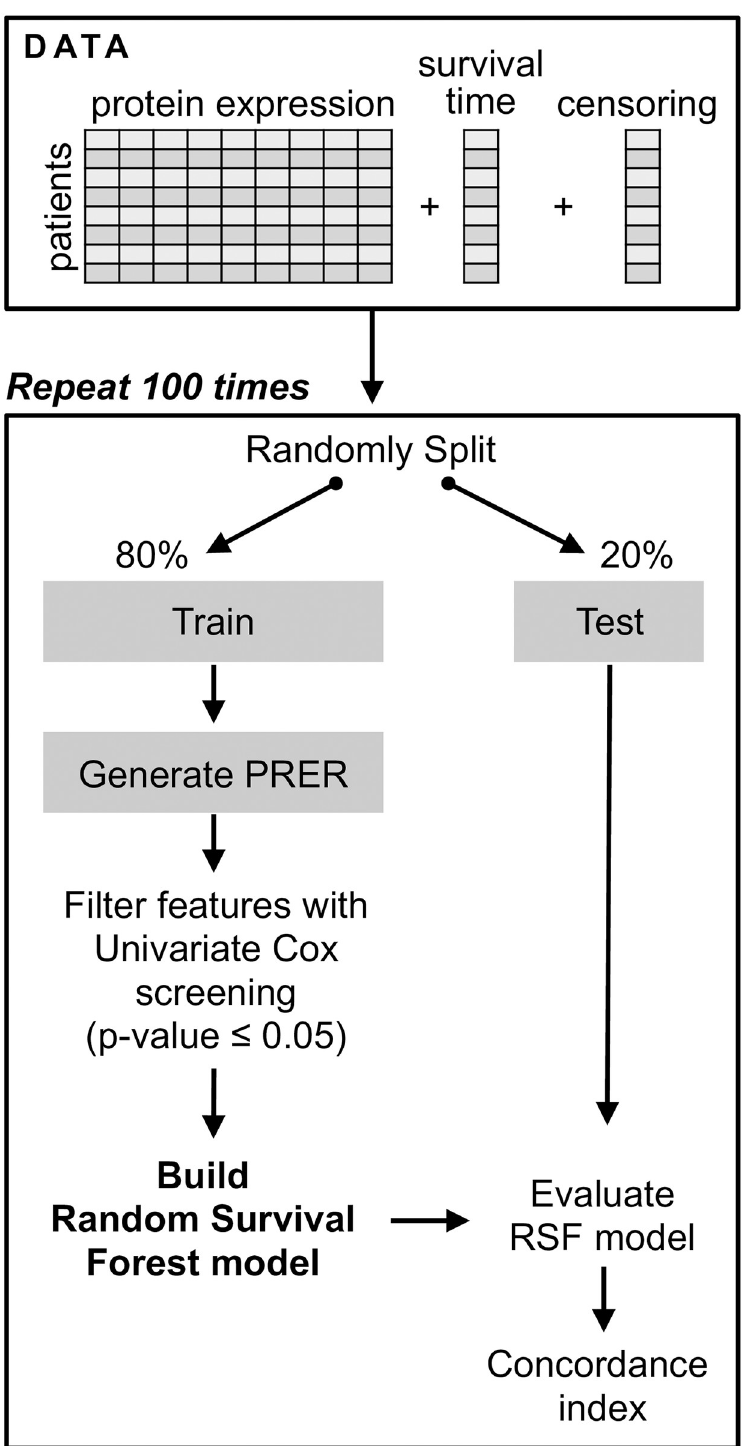
Fig 2. The pipeline for survival prediction. The step that involves generating PRER is skipped when the experiment is run with the alternative method of individual expression values.